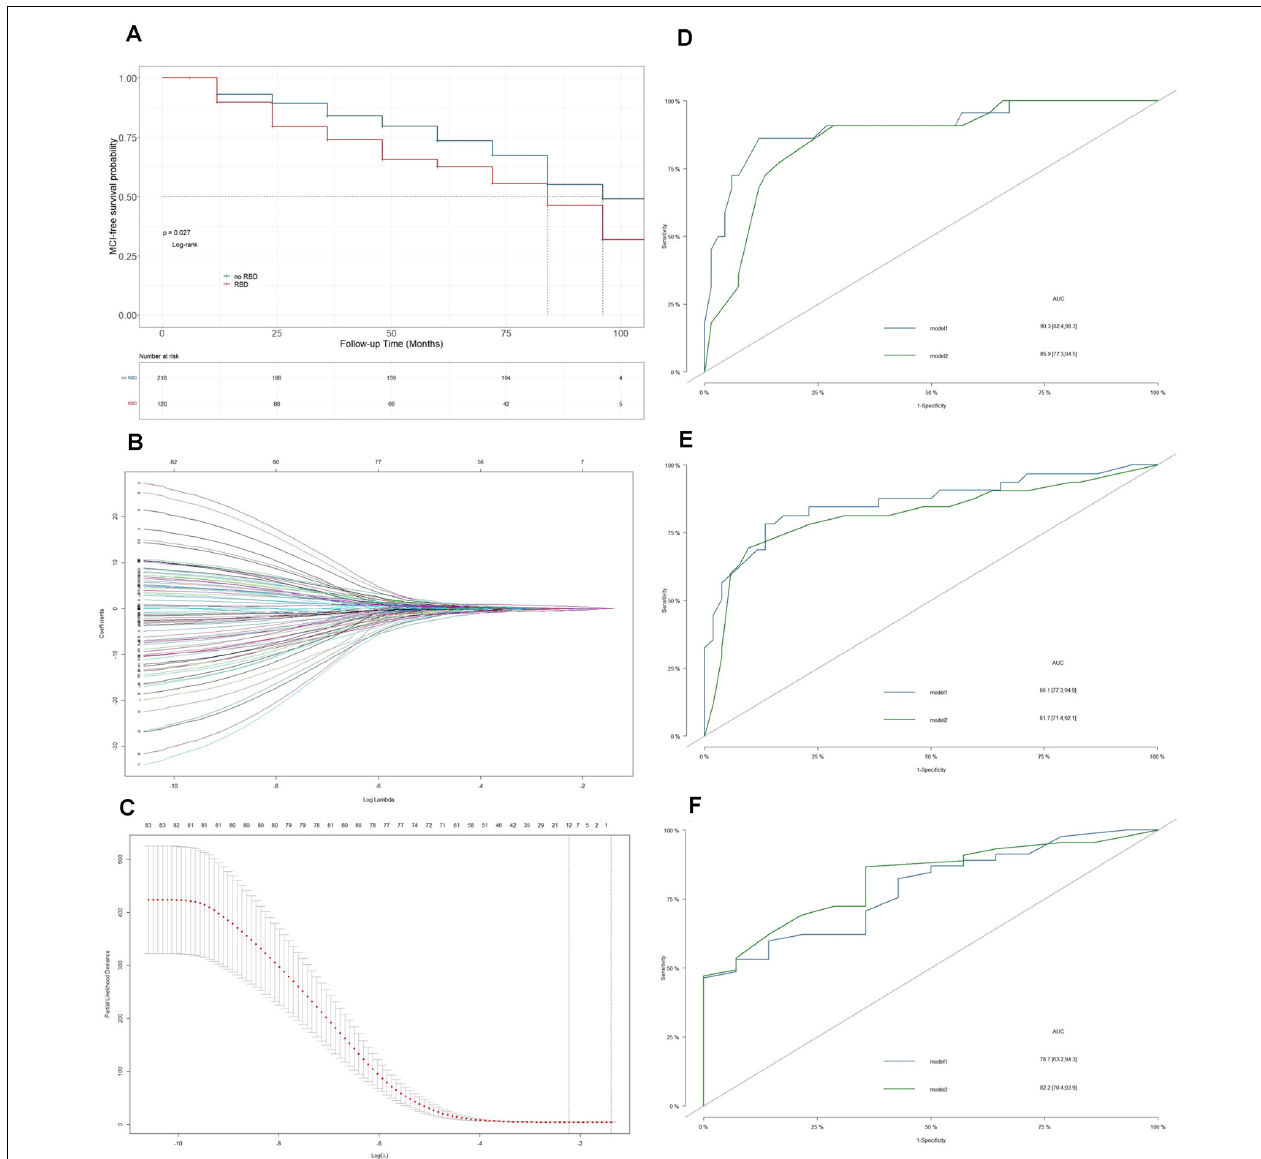
FIGURE 1 | Establishment of the prediction model. (A) Kaplan–Meier plots of mild cognitive impairment (MCI)-free survival between Parkinson’s Disease (PD)-RBD patients and PD-nRBD patients. (B) Optimal parameter selection in the least absolute shrinkage and selection operator (LASSO) regression model. (C) The coefficient profiles of 83 variables in the LASSO model. The lambda we selected resulted in six variables with nonzero coefficients. (D) ROC curves of model 1 and model 2 for predicting MCI in PD-RBD patients at 3 years. (E) ROC curves of model 1 and model 2 for predicting MCI in PD-RBD patients at 5 years. (F) ROC curves of model 1 and model 2 for predicting MCI in PD-RBD patients at 7 years.